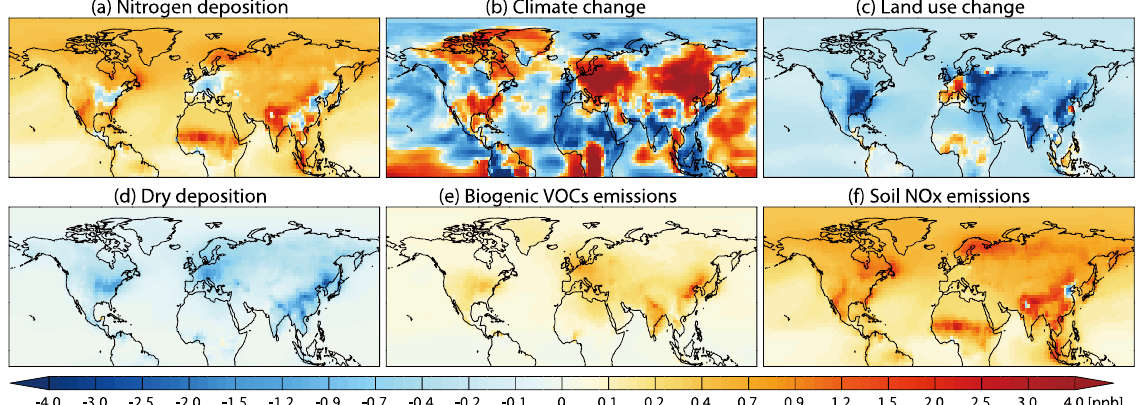
Figure 6. Changes in mean surface ozone concentration for June–July–August driven by anthropogenic nitrogen deposition (top-left panel), changes in climate (2006–2010 vs. 1986–1990; top-middle panel) and land use (present-day vs. 1860 conditions; top-right panel). Model simulations are described in the text. Bottom panels separate the anthropogenic-nitrogen-deposition-induced ozone changes into those due to three processes: changes in dry deposition velocity, biogenic VOC emissions, and soil NO x emissions.